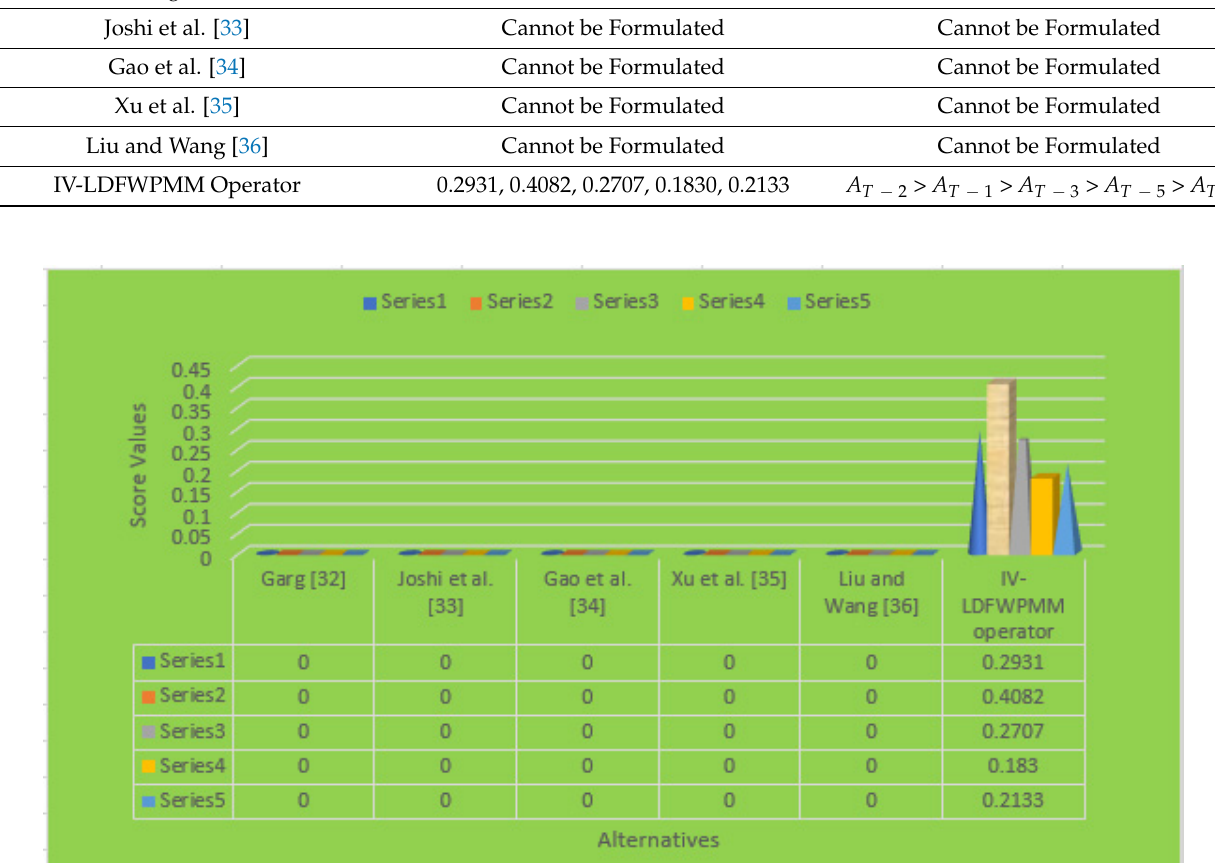
Figure 3 . Geometrical representation of the information given in Table 4. Figure 3. Geometrical representation of the information given in Table Table 4. Comparative analysis of the presented and some existing operators .